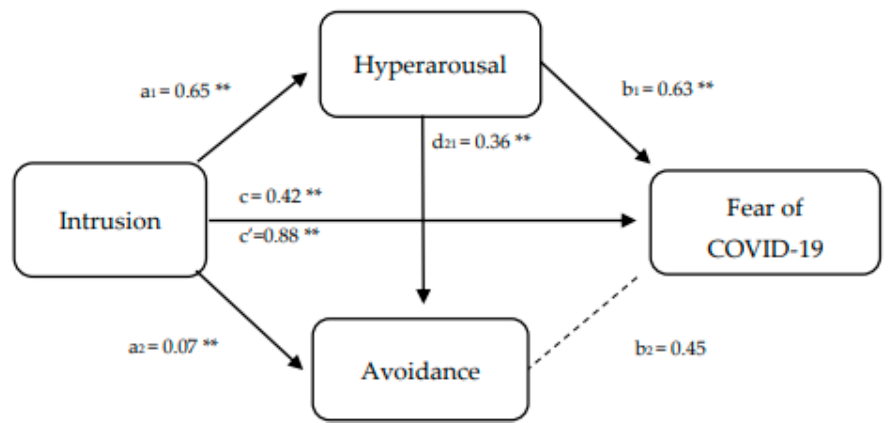
Figure 3. Sequential mediation model proposed to test the associations between intrusive thoughts, hyperarousal, avoidance, and fear of COVID-19. * p < 0.05. ** p <